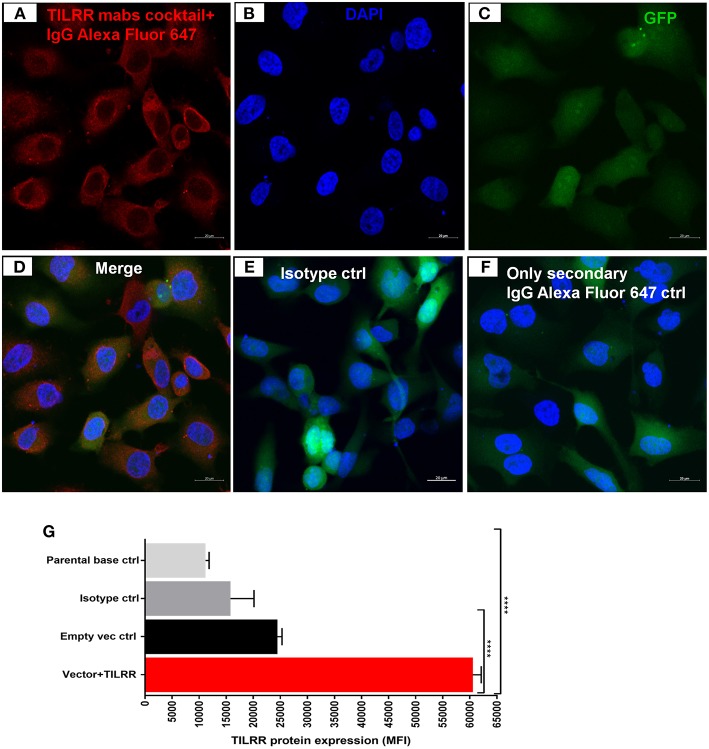
Confocal microscopy and flow cytometry analysis of TILRR protein overexpression in transfected cells. (A) TILRR protein expression in HeLa cells transfected with TILRR plasmid DNA. (B) DAPI staining shown cell nuclei. (C) Transfected cells showing eGFP. (D) Merged expression of TILRR protein, eGFP and nucleus (E) Isotype control monoclonal antibody (F400G3S) staining. (F) Alexa Fluor 647 labeled goat anti-mouse IgG secondary antibody only control. Color code: red, TILRR protein (Alexa Fluor 647 channel); blue, nuclear DNA (DAPI channel); and green, eGFP (FITC channel). Image captured using 20x objectives with 20 μm scale. (G) Flow cytometry confirmation of overexpressed TILRR protein in transfected HeLa cells. Cells were prepared by recommended protocol as illustrated in materials and methods section. The overexpressed TILRR protein confirmed by analyzing the mean fluorescence intensity (MFI) in TILRR-transfected cells compared to the parental base, isotype, and empty vector-transfected control cells. Student t-test with 95% CI performed for the statistical analysis using GraphPad prism version 7.03, all p < 0.05 were reported and indicated using an asterisks' ****p < 0.0001.